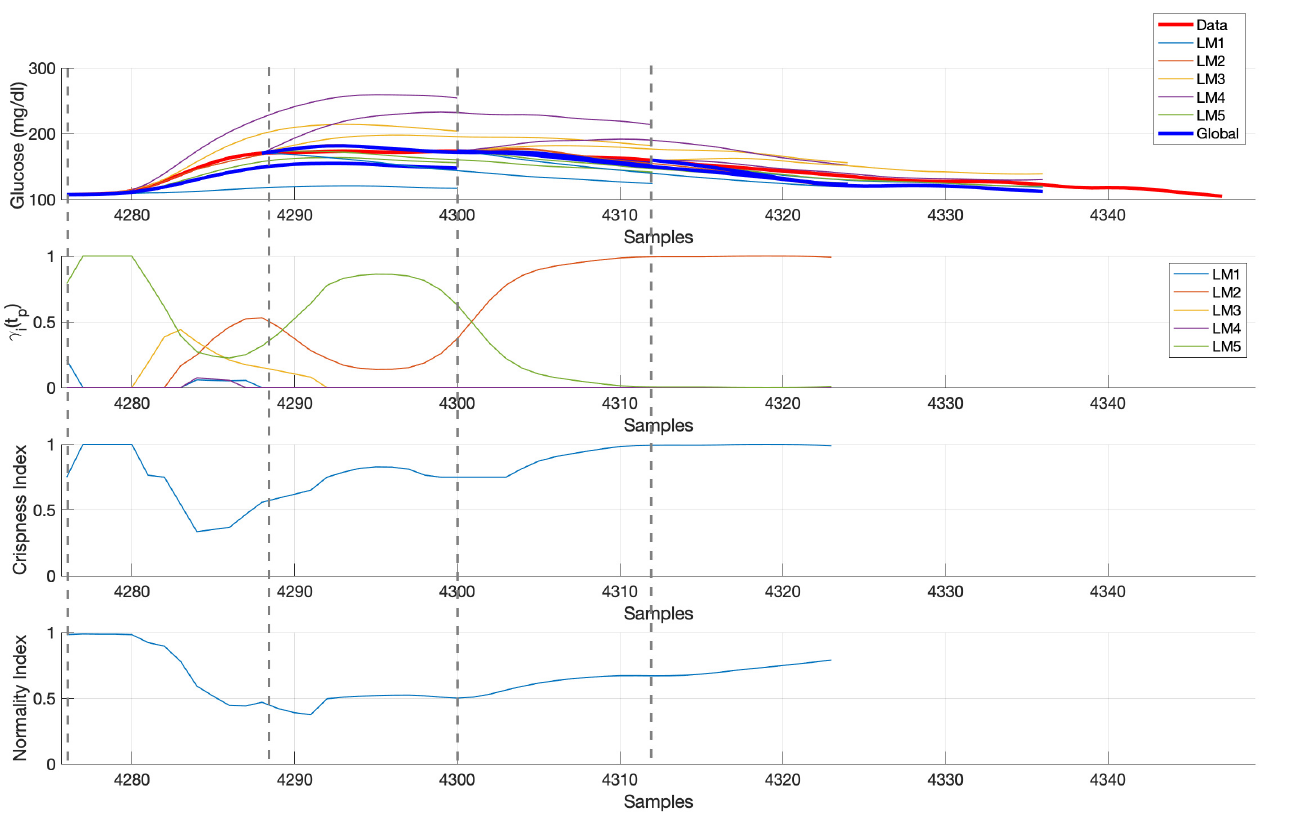
Figure 6. Illustration of the real-time computation of glucose predictions. Vertical dashed lines indicate the start of each 2-h prediction